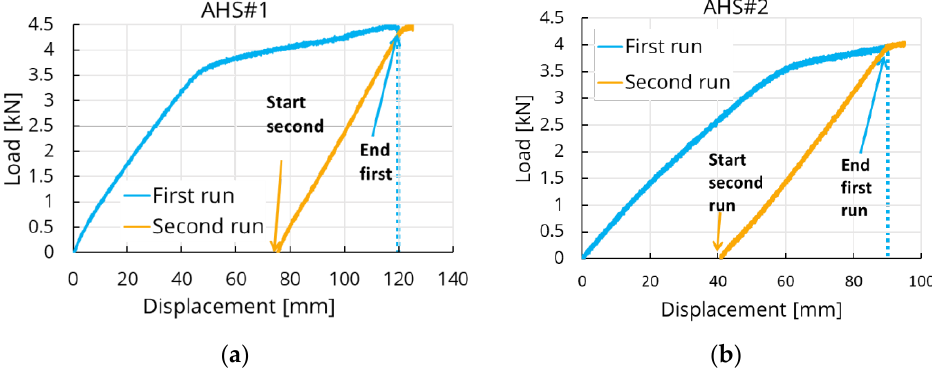
Figure 8. Load – displacement curves for first and second testing phases; ( a ) AHS#1, ( b ) AHS#2. Figure 8. Load–displacement curves for first and second testing phases; ( a ) AHS#1, ( b )